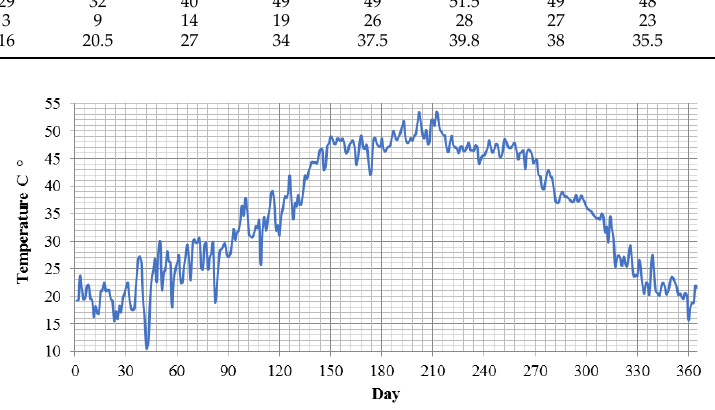
Figure 10. Daily temperature in Ahvaz [80].